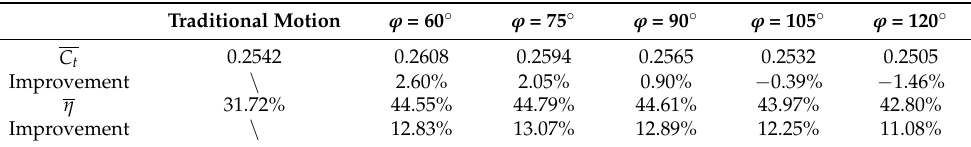
Table 3. Comparison of propulsion performance between different phase differences and traditional two-degree-of-freedom motion under the premise of h 0 = 0.5c and θ 0 = 10 ◦